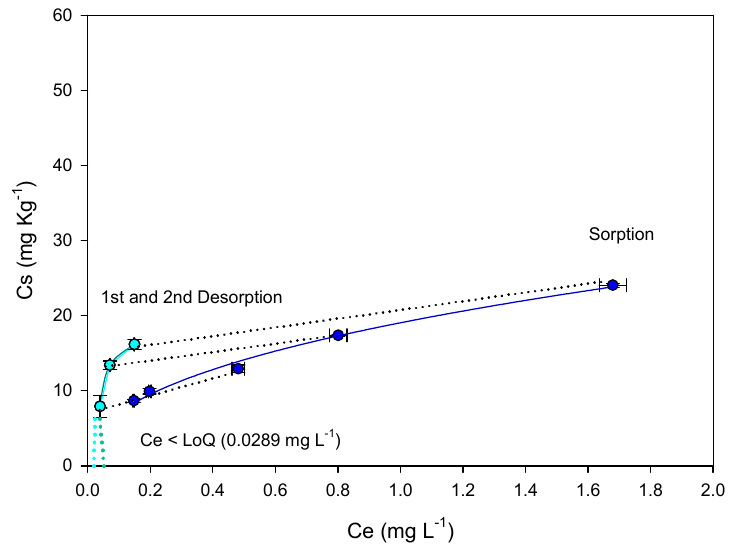
Figure 4. Sorption and desorption isotherms of metribuzin on cellulose acetate film and bonechar (2 g) added to water. The continuous lines in color correspond to the isotherms, and the dotted ones show that no residues of the herbicide were detected (<limit of quantification (LoQ)). The vertical and horizontal bars represent the standard deviation of the means ( n = 3) of the Ce concentration at equilibrium and the Cs concentration in the sorbent, respectively. Symbols can cover the